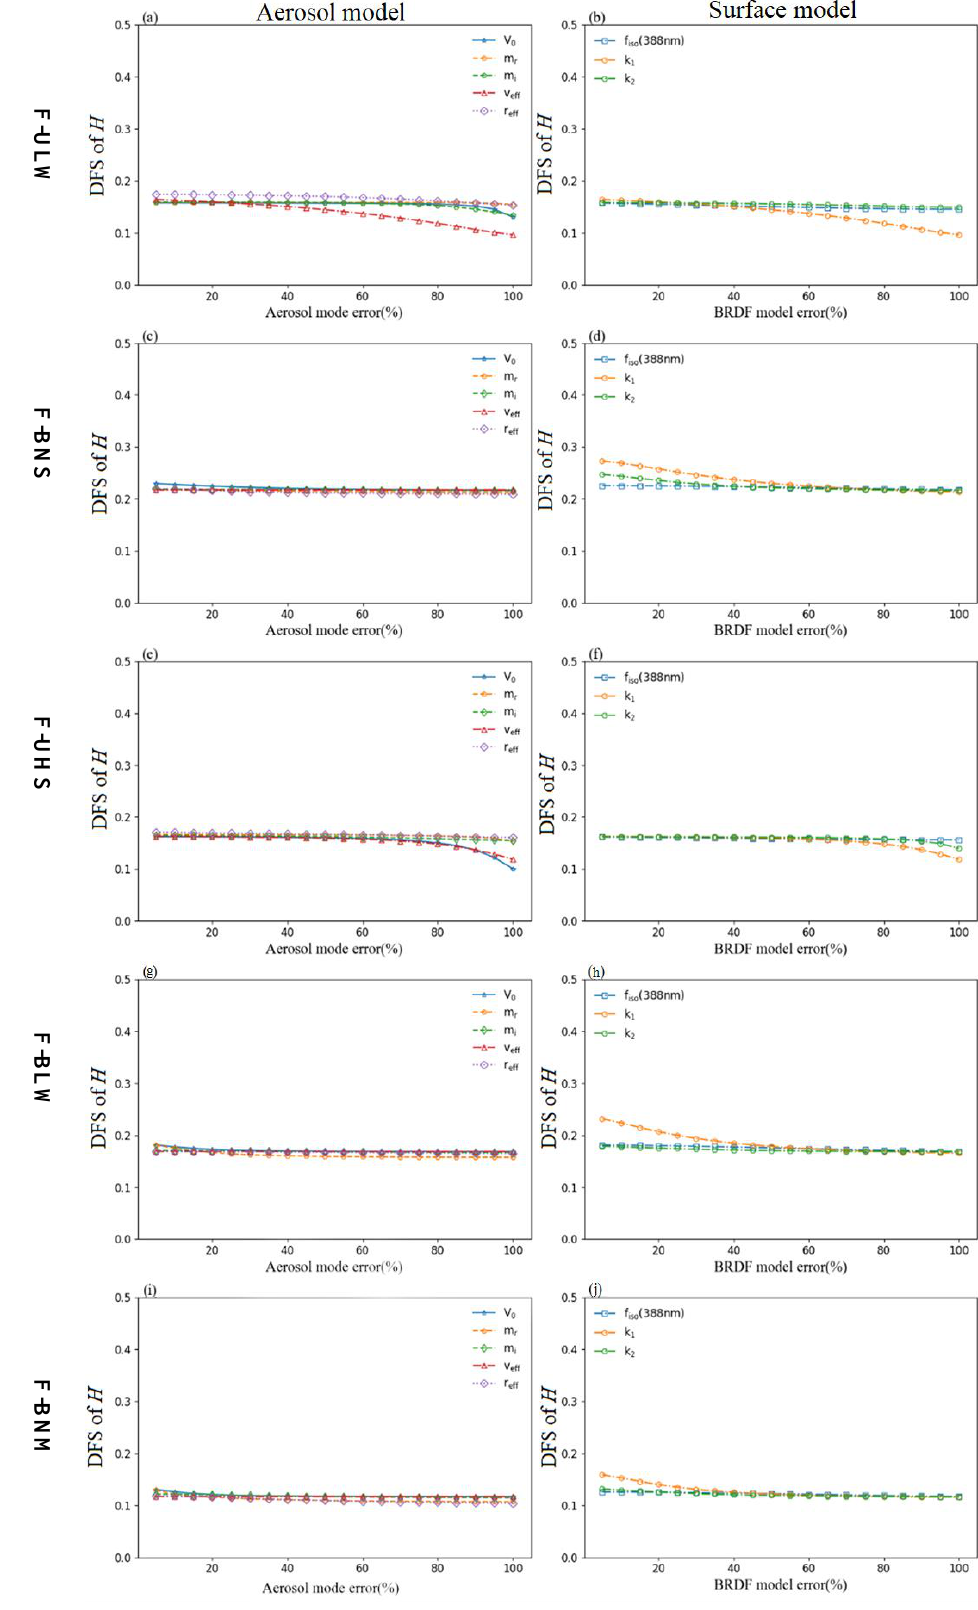
Figure A1. DFS of H as a function of the fine aerosol model and surface model parameter errors from 5% to 100% in steps of 5% but with AOD = 0.2, in which left ( a , c , e , g , i ) and right panel ( b , d , f , h , j ) corresponds to the aerosol model and surface model respectively.